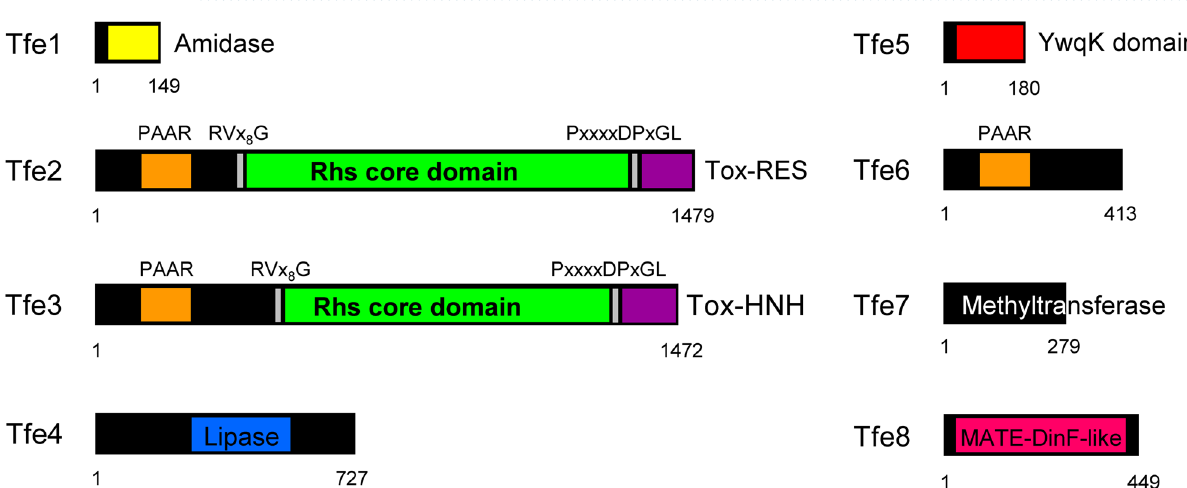
Figure 3. Domain composition of T6SS-related effectors present in P. fluorescens F113. The domain organization of the putative effectors is shown, with amidase domain in yellow, PAAR motifs indicated in orange, RVxxxxxxxxG and PxxxxDPxGL motifs in grey, Rhs domains in green, HNH nuclease motifs (Tox- HNH and Tox-SHH) in purple, YwqK domain in red and MATE domain in pink. Structural-based homology prediction was determined using the Protein Homology/analogy Recognition Engine (Phyre)